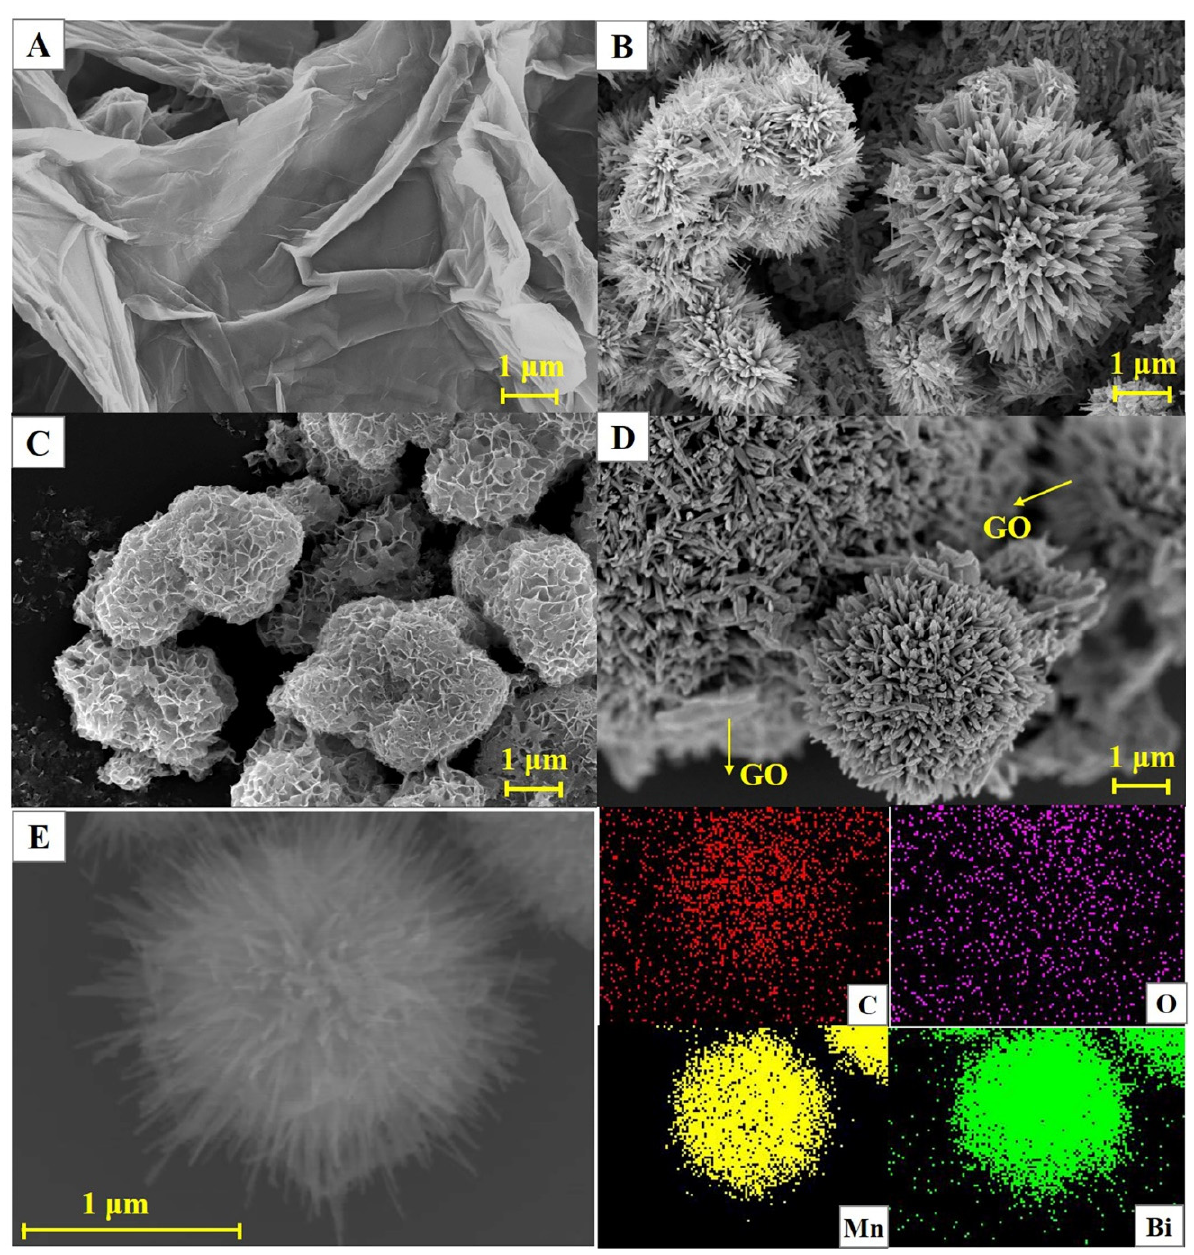
Figure 1. SEM images of the GO nanoflakes ( A ), dandelion-like α -MnO 2 microspheres ( B ), flower- like β -Bi 2 O 3 microspheres ( C ), and Bi 2 O 3 /MnO 2 /GO nanocomposites ( D ). ( E ) EDS mapping of the Bi 2 O 3 /MnO 2 /GO nanocomposites.